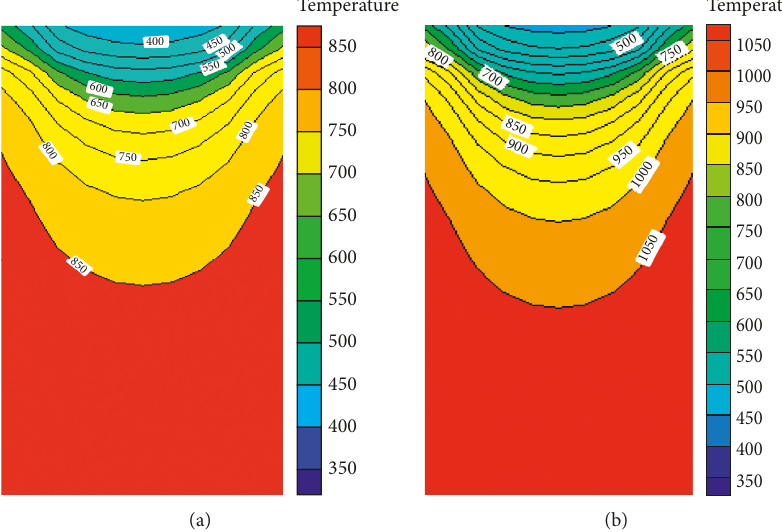
Figure 8: Isotherm contour of section 200mm